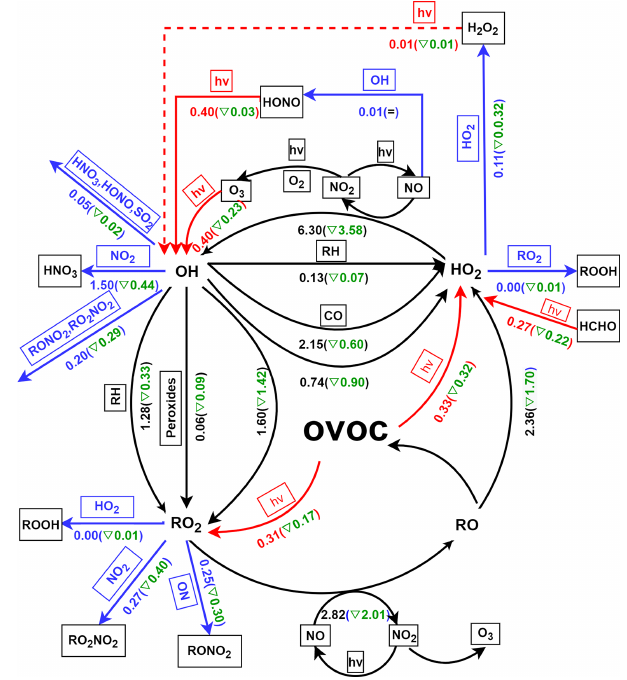
Figure 9. Summary of daytime (06:00–18:00) average budgets of RO x radicals (in ppbvh − 1 ) in S1. Primary RO x sources and sinks are in red and blue, respectively, and the black lines represent the processes in RO x and NO x recycling. Values in the brackets repre- sent the difference between S1 and